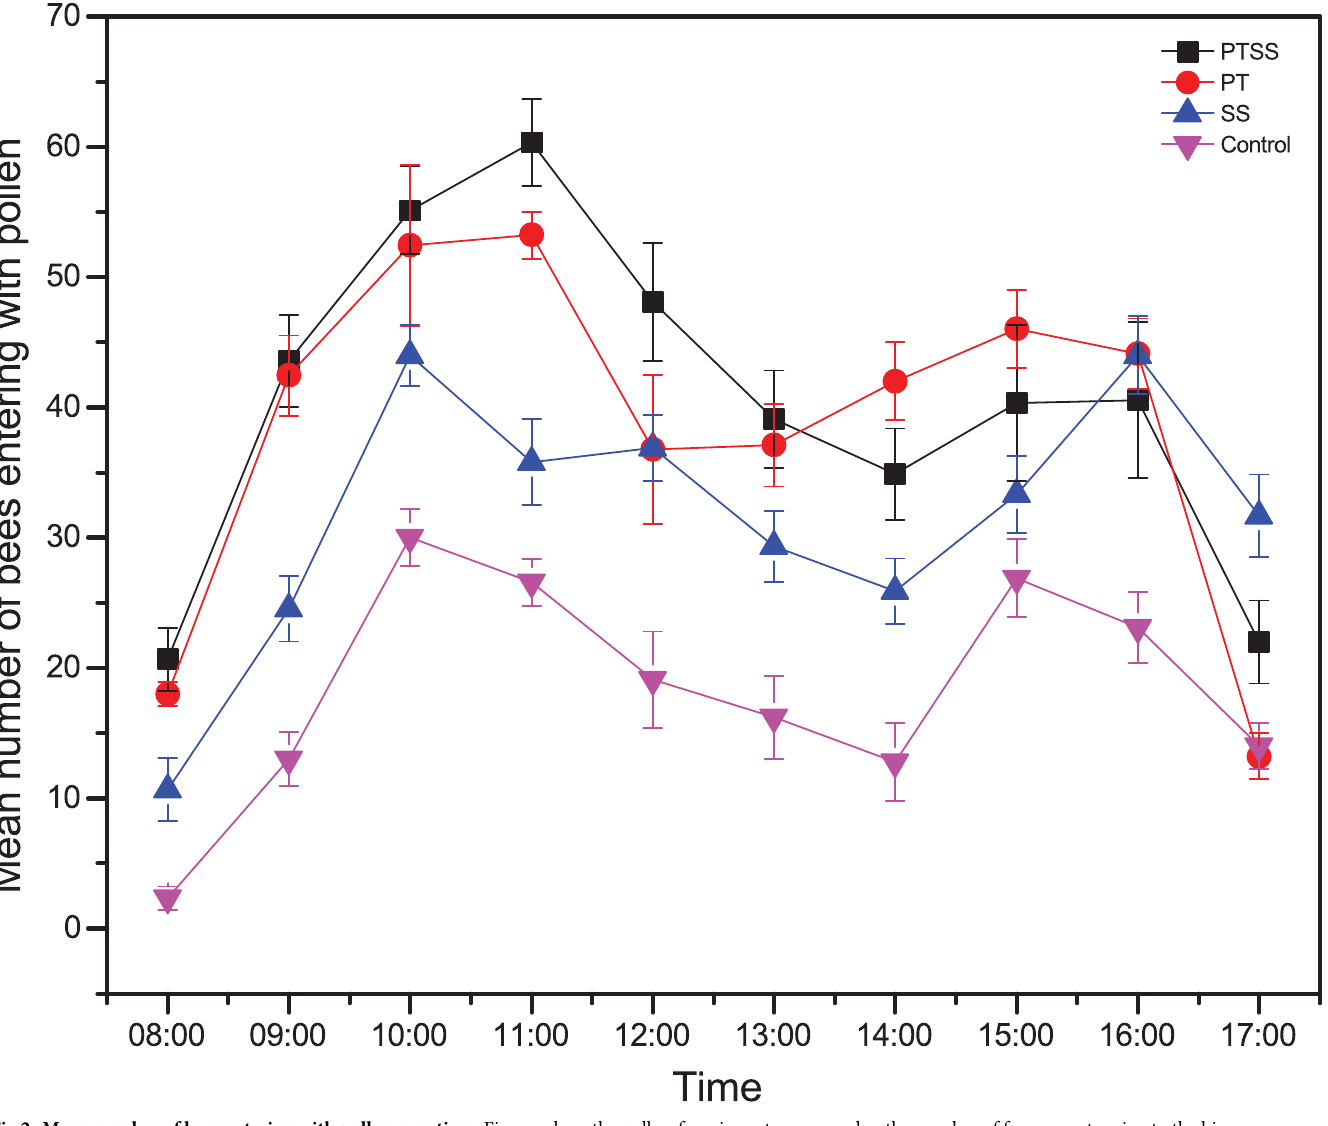
Fig 2. Mean number of bees entering with pollen over time. Figures show the pollen-foraging rate measured as the number of foragers returning to the hive (mean ± se) within a 5-min period over time. The figures show similar pattern with different intensities because of the treatment